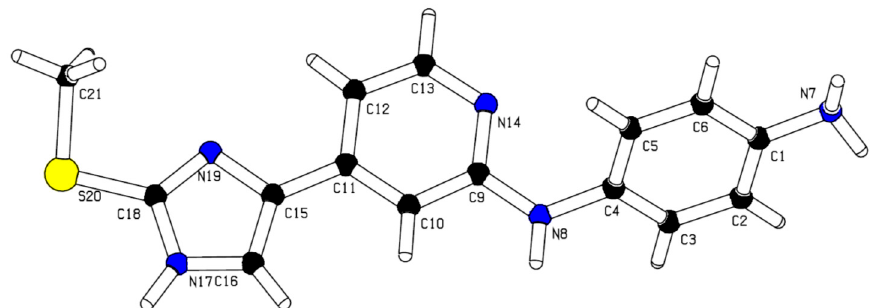
Figure 2. Crystal structure of the title compound 2 .